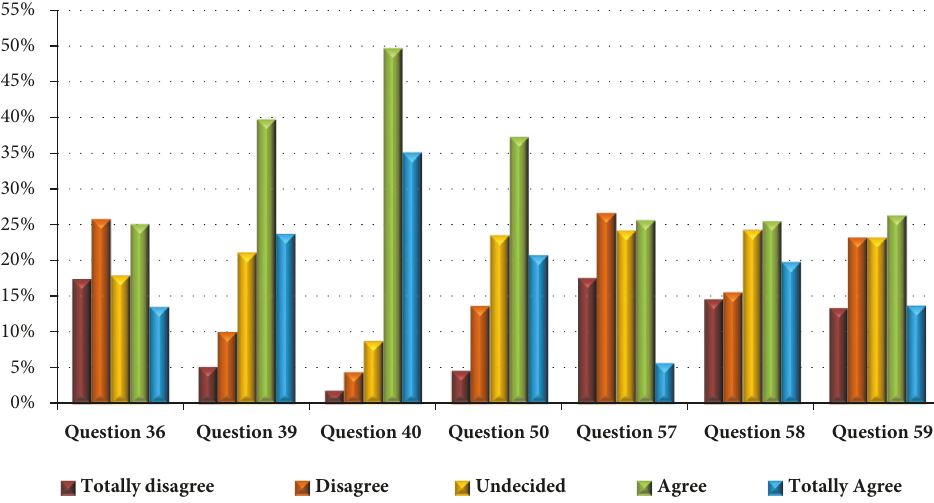
Figure 4: Relative frequency of answers to seven questions of the questionnaire, in the agreement